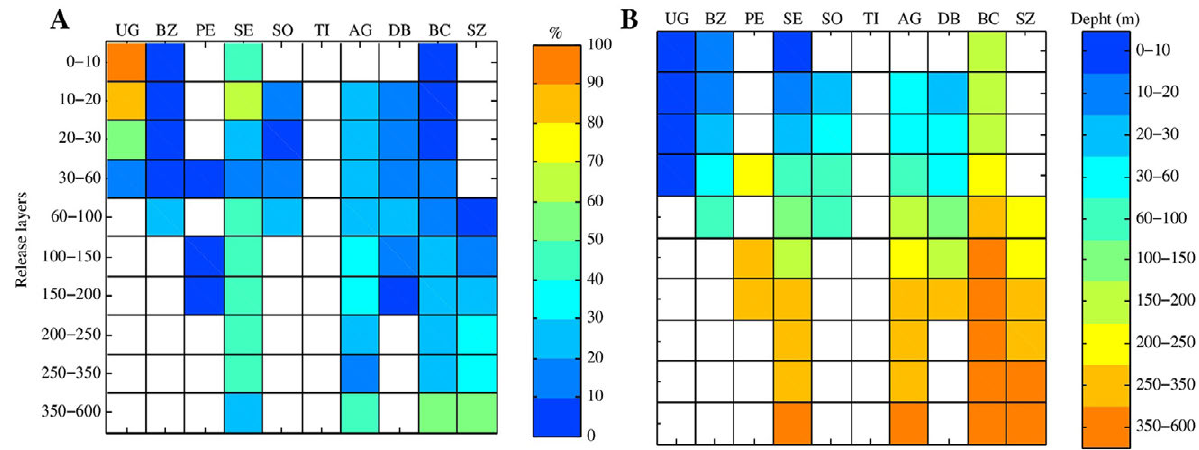
Fig. 3. – A, retention matrix, showing the percentage of particles located in the diagonal of connectivity matrices of each released layer, i.e. the percentage that ends in the same area after eight weeks. B, average depth matrix associated to the retention matrix, which shows the final average depth of the retained particles. The horizontal and vertical axes denote the area and layer of release, respectively. For clarity, cells with connectivity less than or equal to 5% are not coloured. Note that the final vertical position can be different from the released